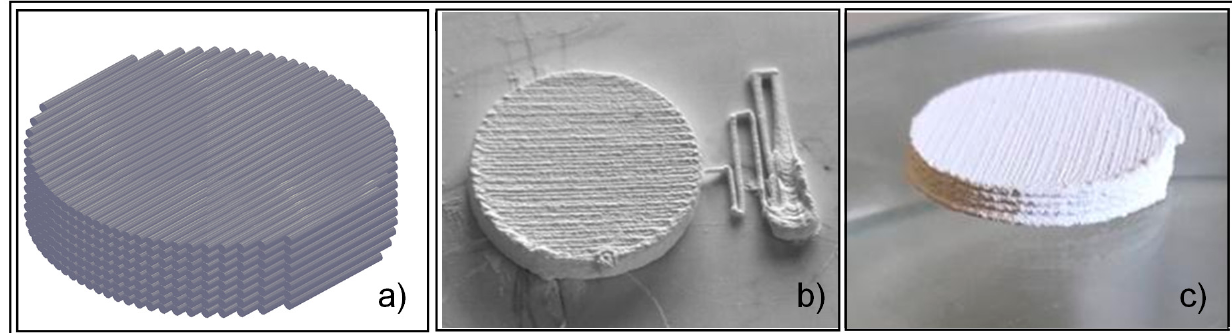
Figure 1. ( a ) Schematic representation of filament layers deposition during 3D building; ( b ) printed Al 2 O 3 –Y 2 O 3 sample; ( c ) after drying for 48 h.